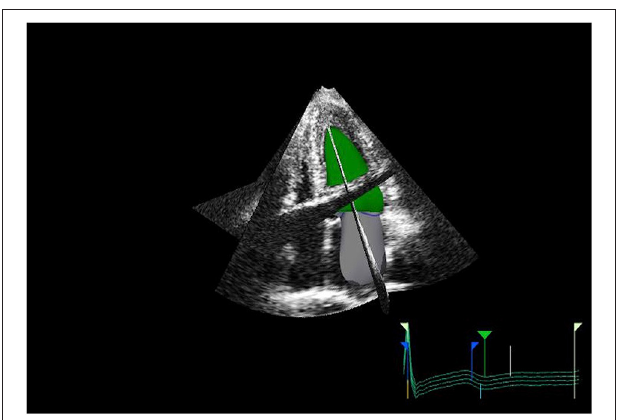
FIGURE 1 | 3D echo reconstruction of the left atrium (LA) and left ventricle (LV). LA is shown at its end-diastolic phase in order to appreciate left maximal atrial